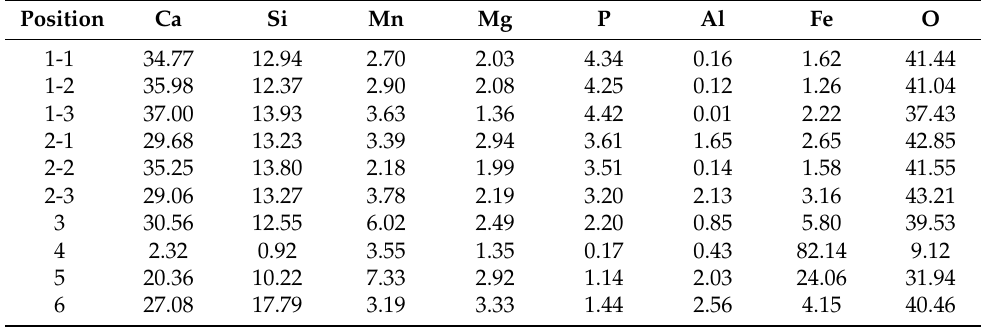
Table 4. Element compositions of different phases in dephosphorization slag by SEM-EDS point